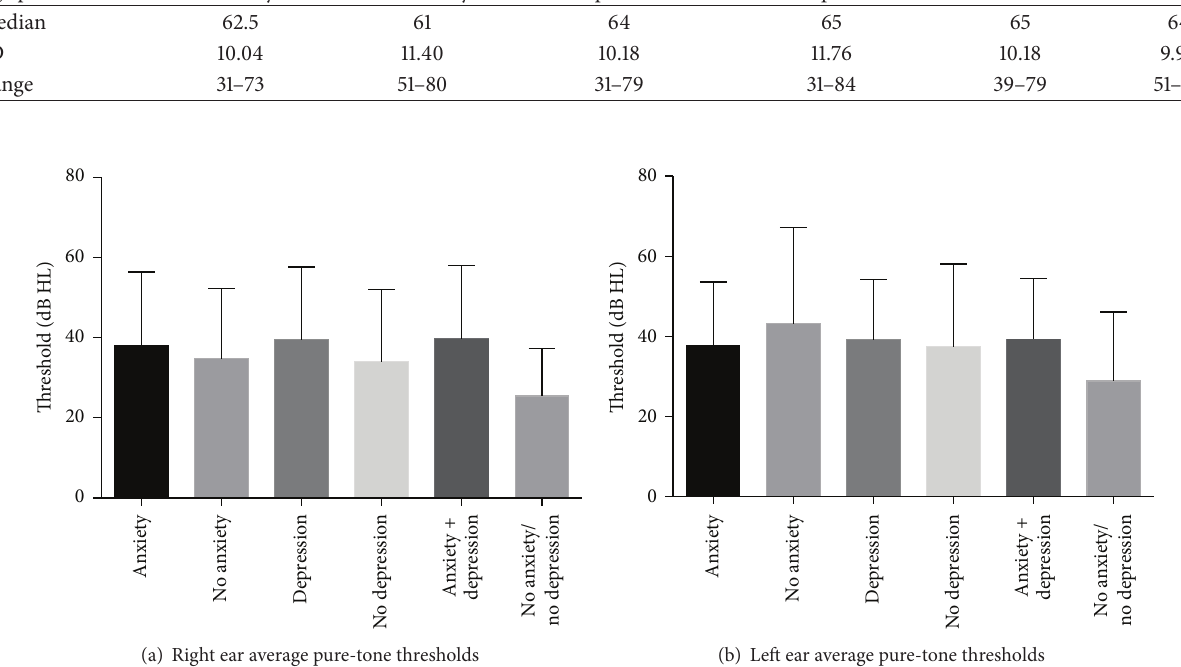
IBM Corporation, Armonk, NY) was used for statistical analysis. 𝑝 value was considered significant when 𝑝 < 0.05